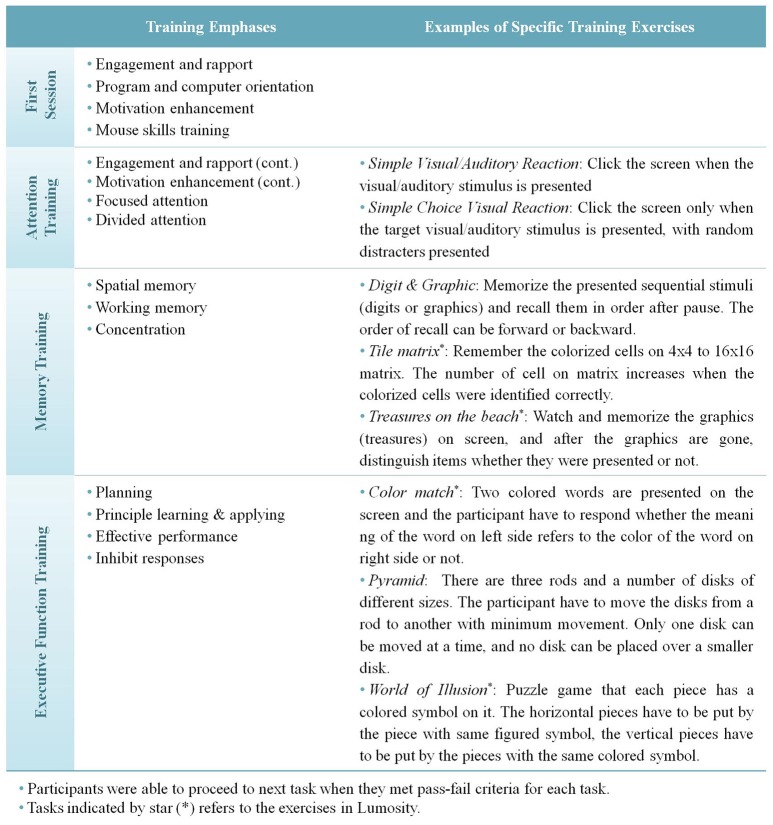
Targeted domains and detailed training tasks in CR.